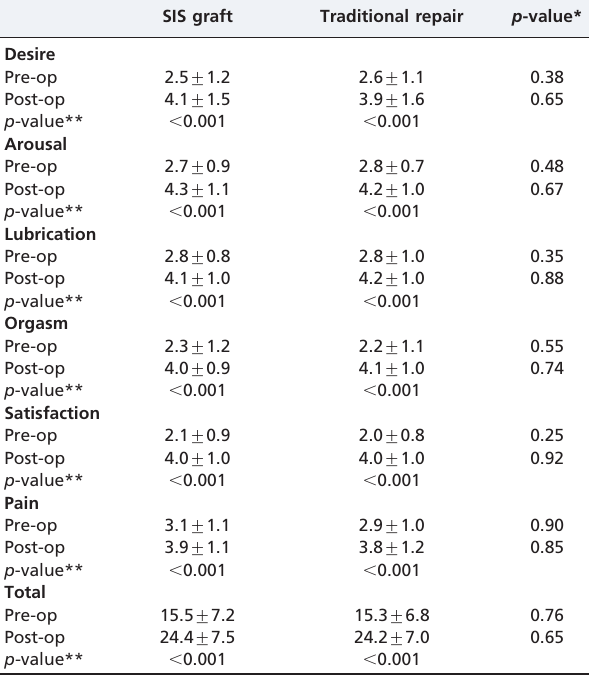
Table 2 - Preoperative and postoperative FSFI scores of women who underwent SIS grafting or traditional anterior repair. Values are given as the means ( ¡ standard